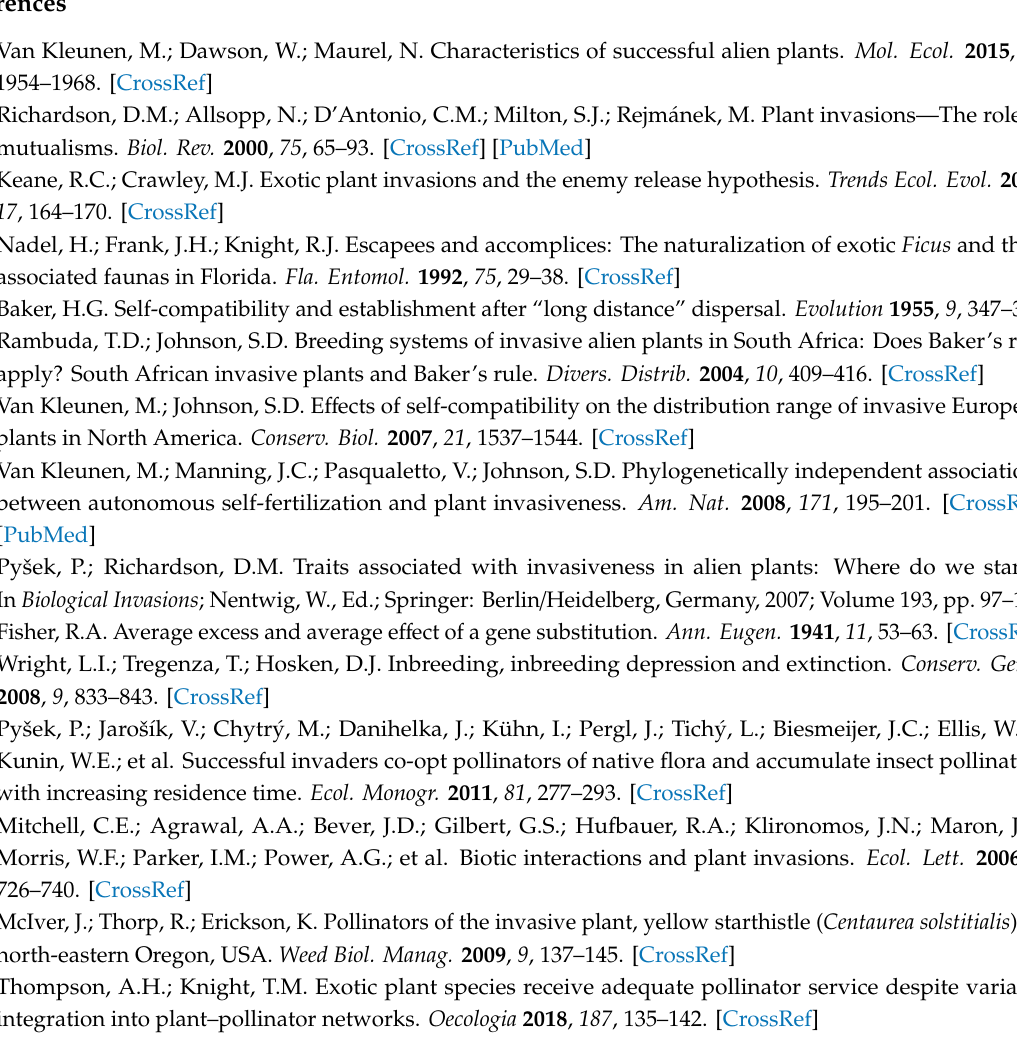
Table S1: List of the study species with invasion status, minimum residence time, German range size, and seed sources. Treatments in which species flowered and produced seeds are indicated, with respective number of individuals (out of total number of individuals); Table S2: Number and type of potential pollinators that visited plants depending on invasion status; Table S3: Percentage of germinated seeds in the treatment where pollinators had free access, were excluded and totalled; Figure S1: Starting and final height depending on treatment; Figure S2: Number of ripe seeds depending on invasion status; Figure S3: Seed ripening day (day after transplanting) depending on invasion status; Figure S4: Range size in Germany depending on invasion status; Figure S5: Phylogenetic relationships among